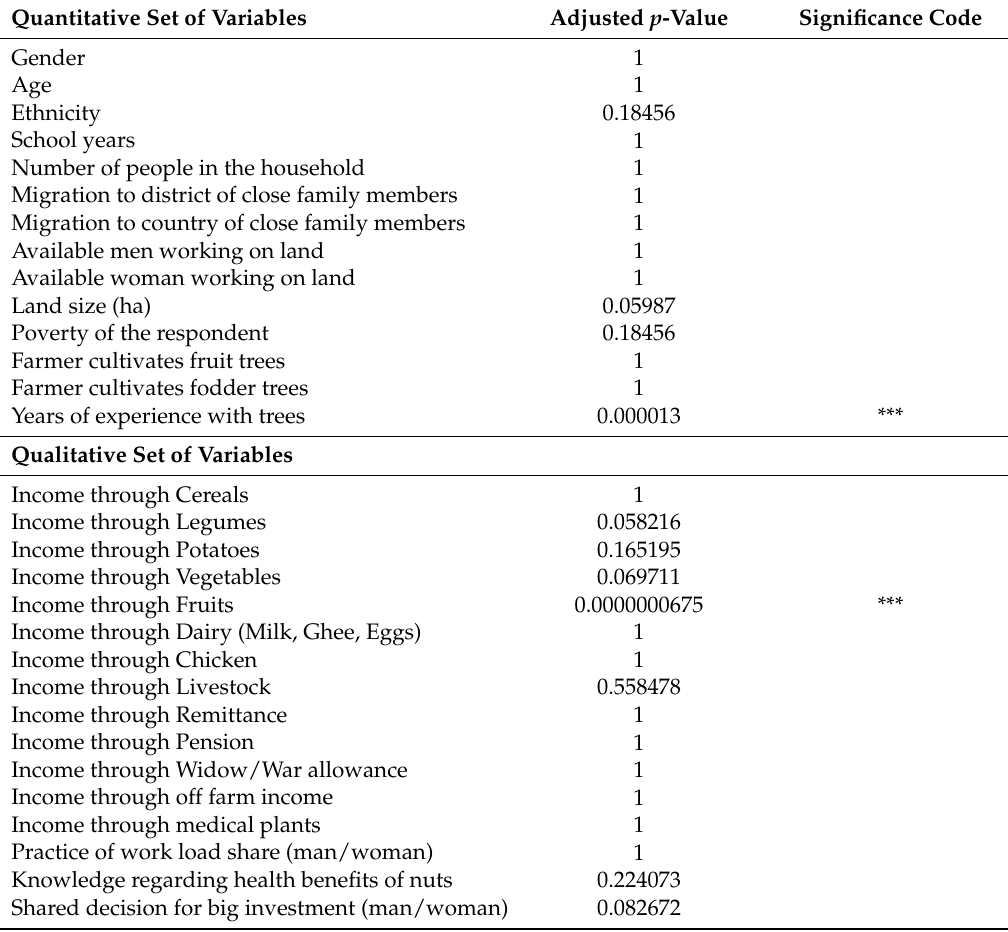
Table A2. Full Result logistic regression with adjusted p